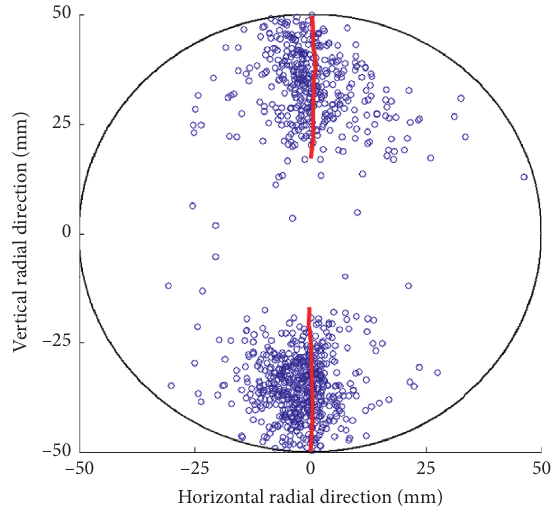
Figure 5: Typical spatial distribution of AE signals. Note that black line represents the boundary of rock specimen and red lines refer to macroscopic cracks distributed in rock